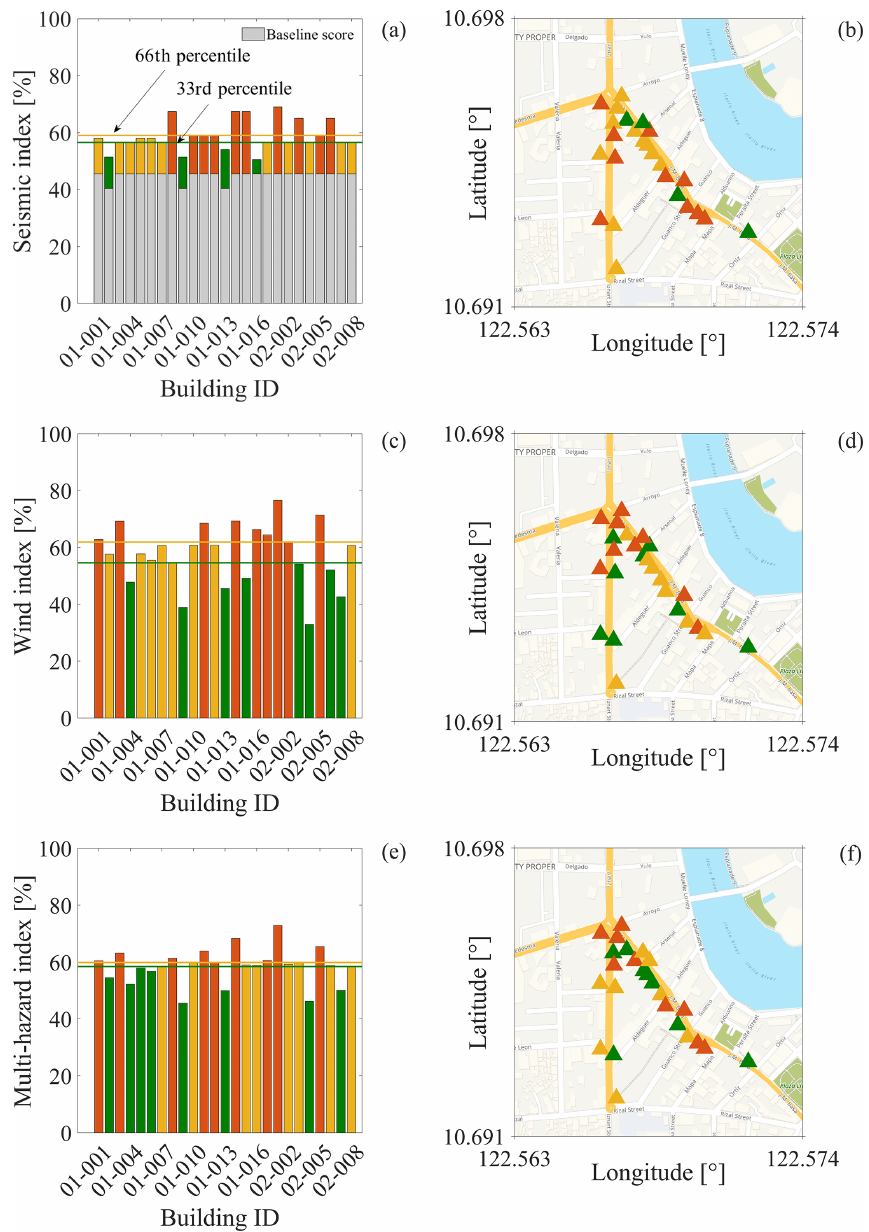
Figure 8. Prioritisation indices: (a) seismic-risk prioritisation index; (c) wind-risk prioritisation index; (e) multi-hazard risk prioritisation index. Panels (b) , (d) and (f) show the corresponding locations of buildings. Background map by © OpenStreetMap contributors, 2019. Distributed under a Creative Commons BY-SA